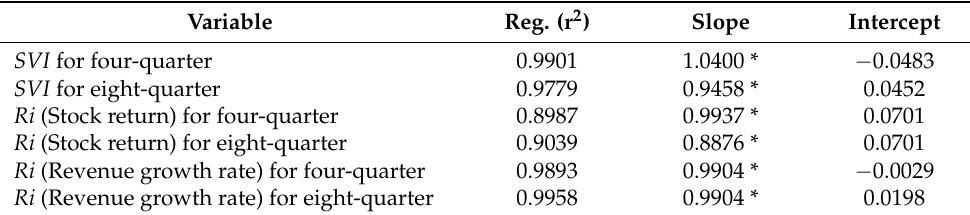
Table 3. Regression